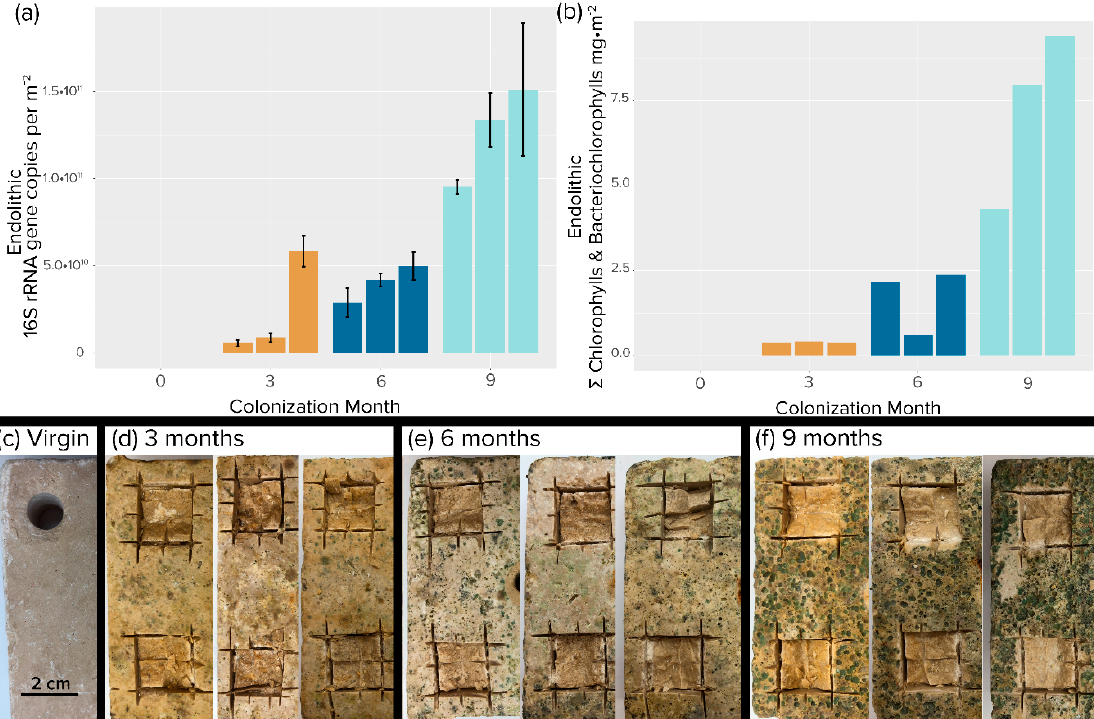
Figure 2. Endolithic colonization of travertine tiles. ( a ) Areal concentration of 16S rRNA gene copies. Each bar is an independent replicate. Error bars are from biological replicates. ( b ) Areal concentration of total photosynthetic chlorins (chlorophylls plus bacteriochlorophylls). Single determinations were carried out for each replicate tile. ( c – f ) Photographic evidence of colonization after removal of epilithic biomass by brushing. ( c ) Initial, virgin tile. Excising squares were samples used for analyses.